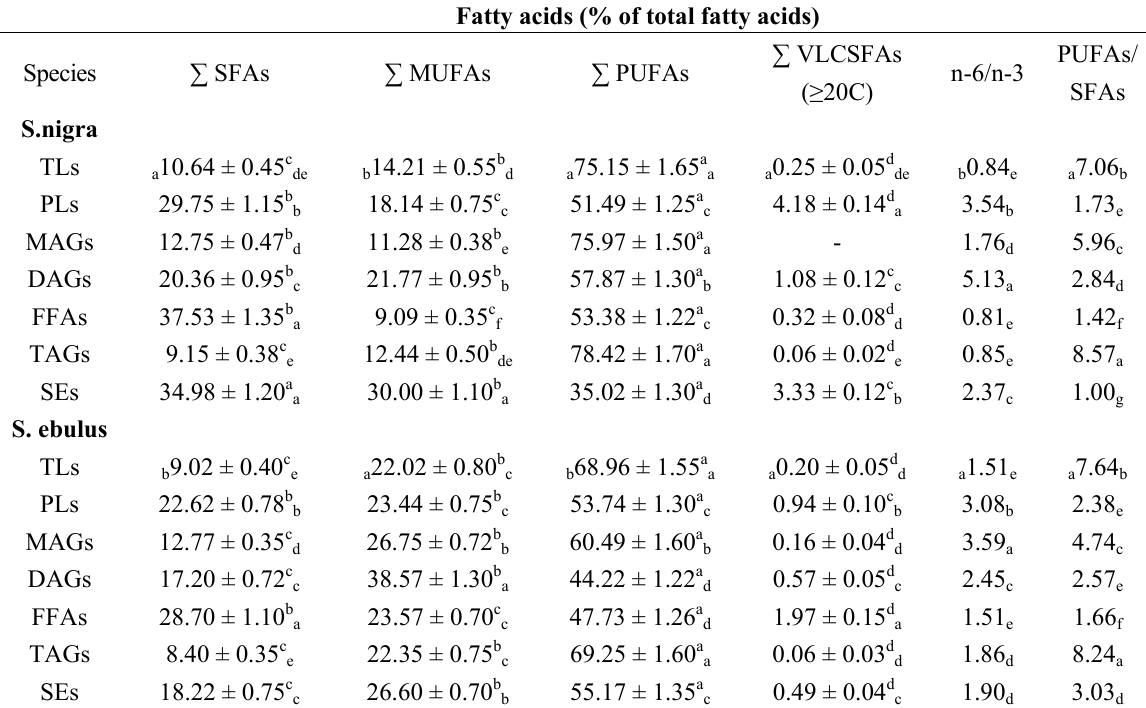
Table 2. The composition (%) of fatty acid classes in total lipids and major lipid fractions. Fatty acids (% of total fatty acids)